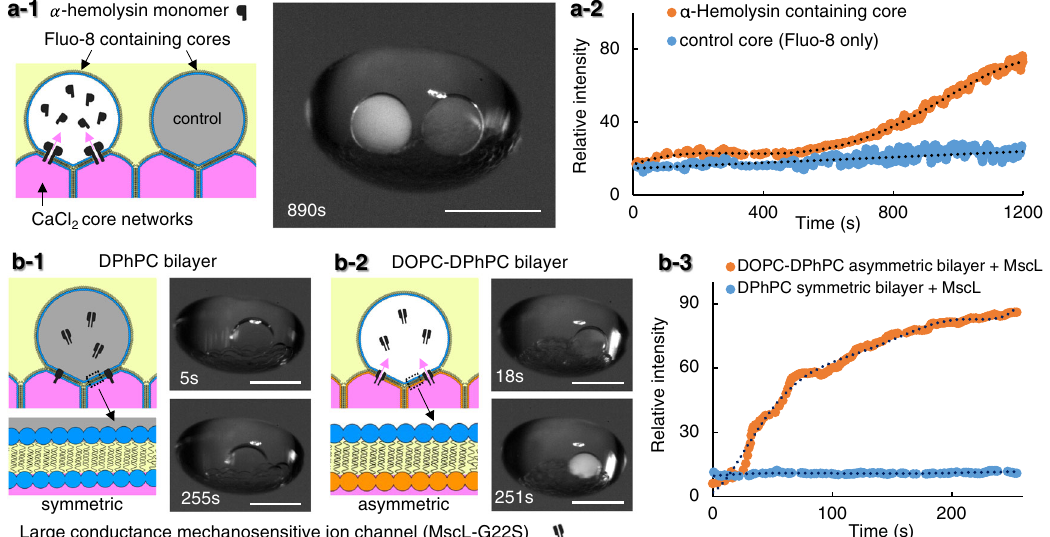
Fig. 4 Reconstitution of functional alpha-hemolysin pores and bacterial MscL protein channels into the arti fi cial membranes of the core network of levitated ACDC droplets. a - 1 Alpha-hemolysin (aHL) monomers contained in an internal core bind to the membrane separating neighbouring droplets and assemble into heptameric protein pores in the DPhPC bilayer. Ca 2 + ions diffuse through aHL pores moving from the source cores to the protein-containing core where fl uorescence is induced by the presence of the calcium-sensitive fl uorophore, Fluo-8. No ion- fl ux is observed in an identical control droplet without aHL monomer. a - 2 The graph indicates the fl uorescence intensity over time of both aHL containing and non-aHL containing (control) droplets in the levitated arti fi cial cells with distributed cores (ACDC droplet) over 20min. (Dotted lines = moving average). b The mechanosensitive channel, MscL, opens in response to membrane tension. Gating of MscL channels in levitated ACDC droplets with membranes of different bilayer lea fl et compositions. b - 1 In symmetric DPhPC bilayer networks no Ca 2 + fl ux is observed, the channel remains closed; b - 2 In asymmetric DOPC-DPhPC bilayer networks asymmetric membrane tension is induced, opening MscL channels, and giving rise to Ca 2 + fl ux and observed fl uorescence. (No fl uorescence increase is observed in the absence of MscL (SI)) b - 3 , Time-course fl uorescence in symmetric (DPhPC) and asymmetric (DOPC-DPhPC) membranes with incorporated MscL as depicted in b - 1 and b - 2 . Asymmetric membrane tension-induced activation of MscL channels enables Ca 2 + fl ux, eliciting maximal fl uorescence response over the course of 250s (orange trace). No fl uorescence increase is observed in the symmetric membrane system (blue trace) indicative of channel inactivation, as well as the asymmetric membrane without MscL reconstitution (Fig. S11). All scale bars = 1 mm.